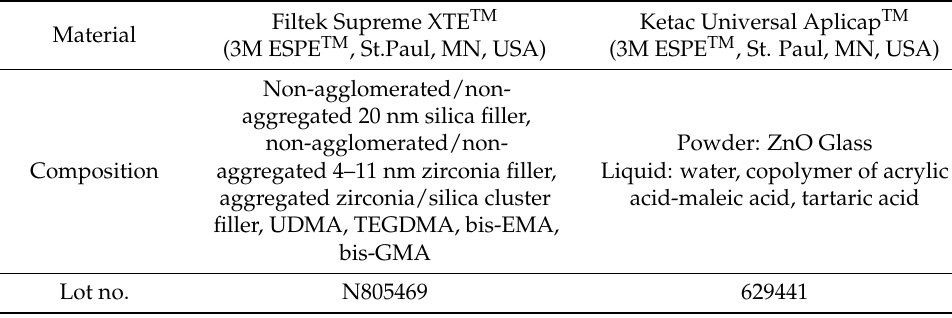
Table 1. Characteristics of restorative materials used in the present study. Filtek Supreme XTE TM Material (3M ESPE TM , St.Paul, MN, USA) Non-agglomerated/non- aggregated 20 nm silica filler, non-agglomerated/non- Powder: ZnO Glass Composition aggregated 4–11 nm zirconia filler, Liquid: water, copolymer of acrylic aggregated zirconia/silica cluster acid-maleic acid, tartaric acid filler, UDMA, TEGDMA, bis-EMA, bis-GMA Lot no. N805469